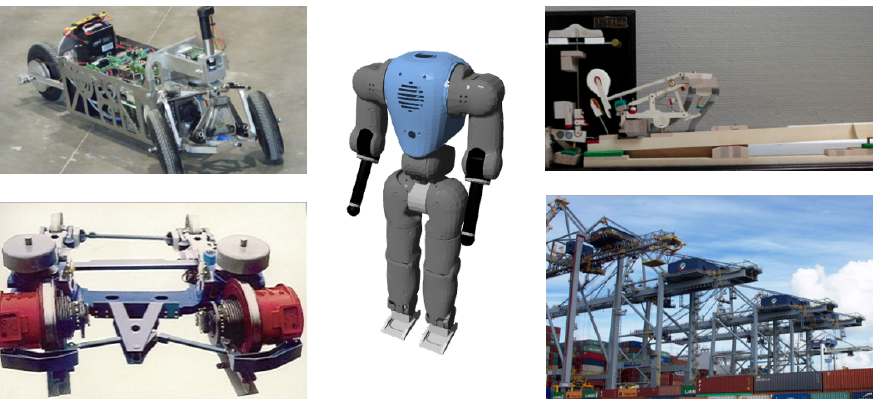
Figure 1. Multibody applications range from small piano action, through road and railway vehicles, to huge port cranes